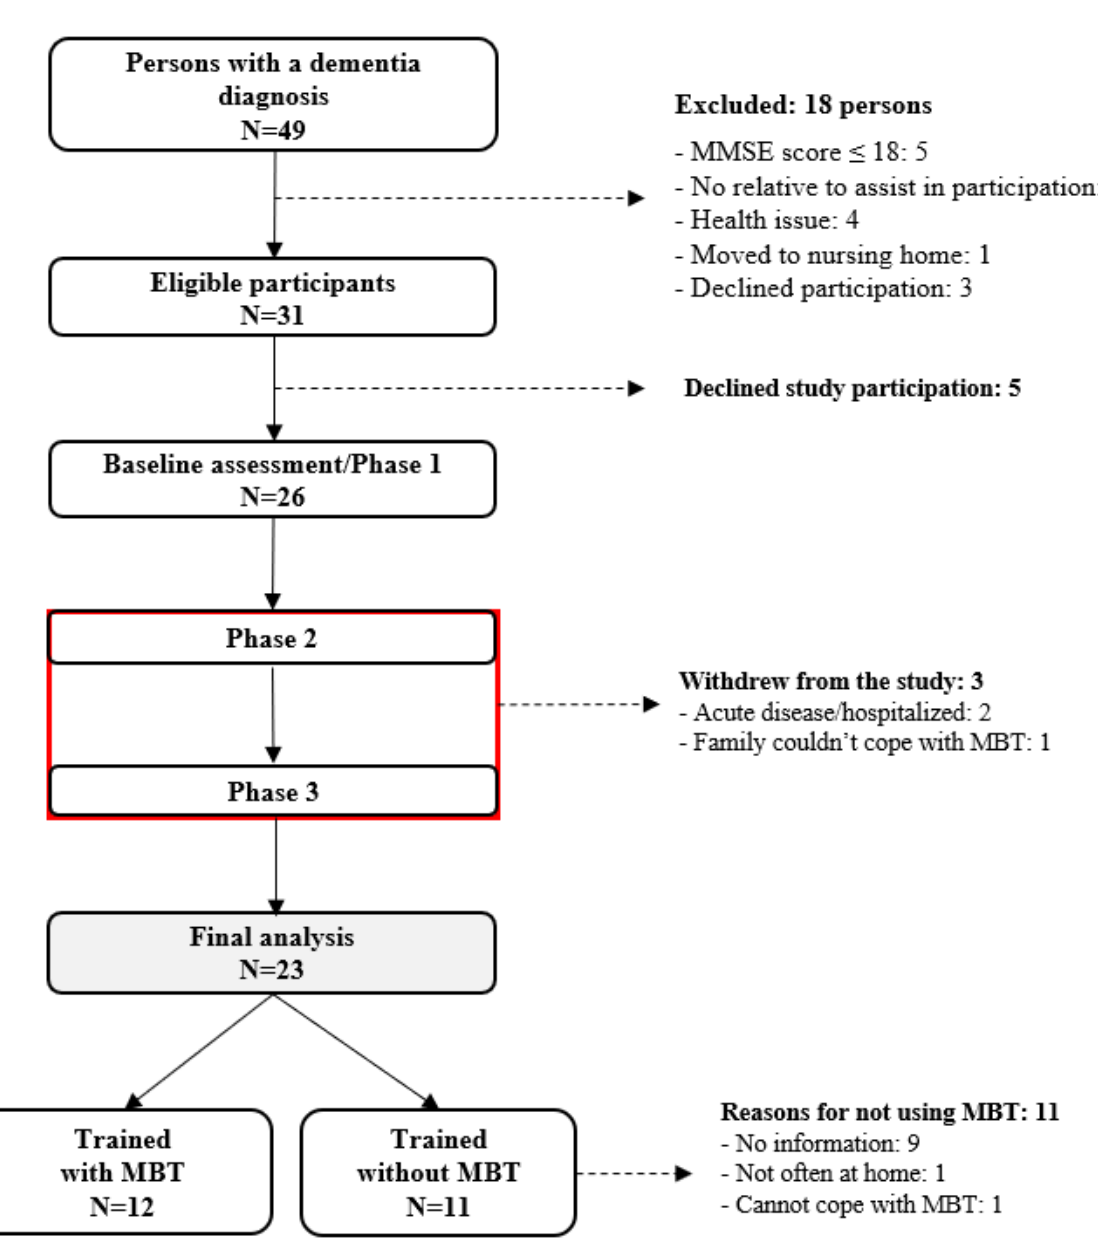
Figure 4. Flowchart of study